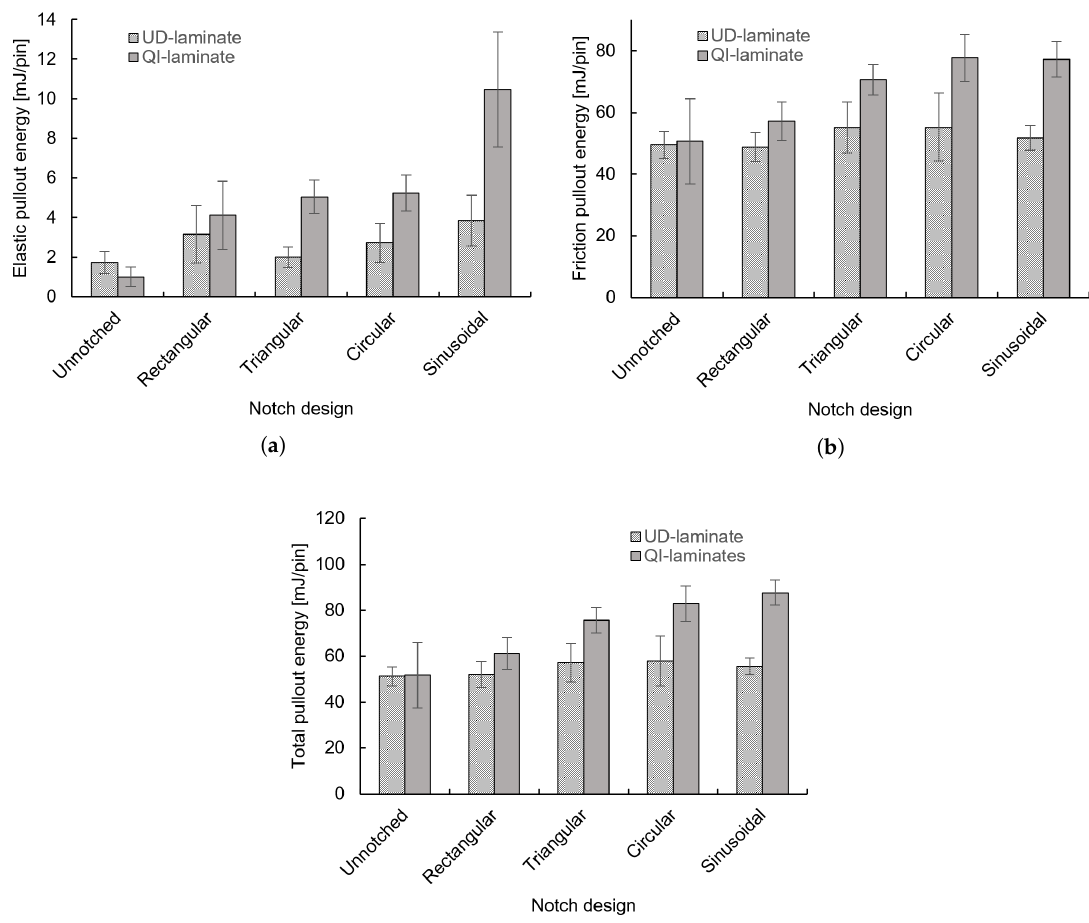
Figure 8. Mean values and corresponding standard deviation of elastic ( a ), frictional ( b ), and total ( c ) pullout energy dissipated during z-pin pullout of unnotched and circumferentially notched z-pins with different notch designs in unidirectional and quasi-isotropic